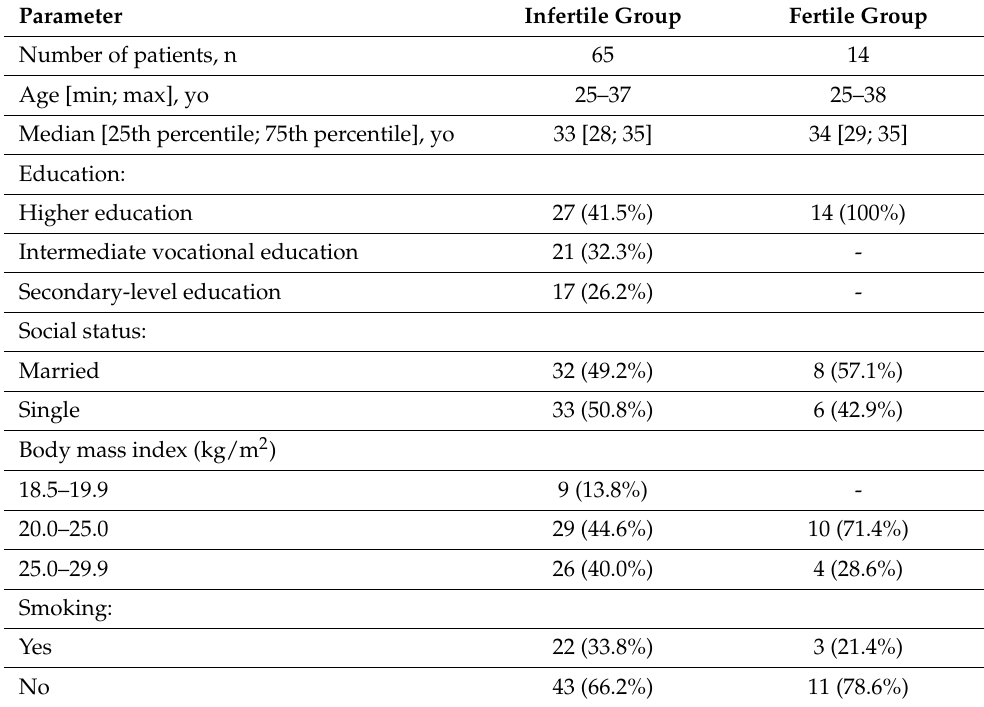
Table 5. Clinical and social parameters in groups